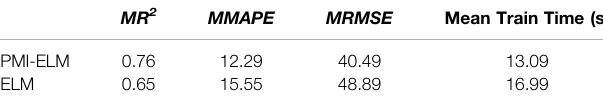
TABLE 8 | Statistical indicators of the prediction using different methods.